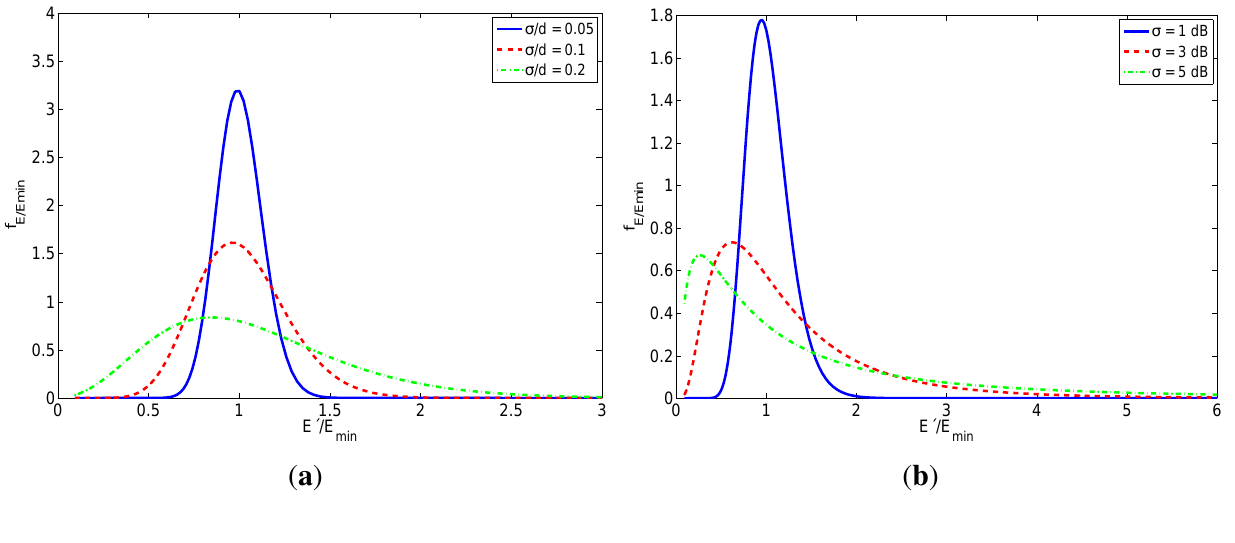
for TOA-based and RSS-based localization obj